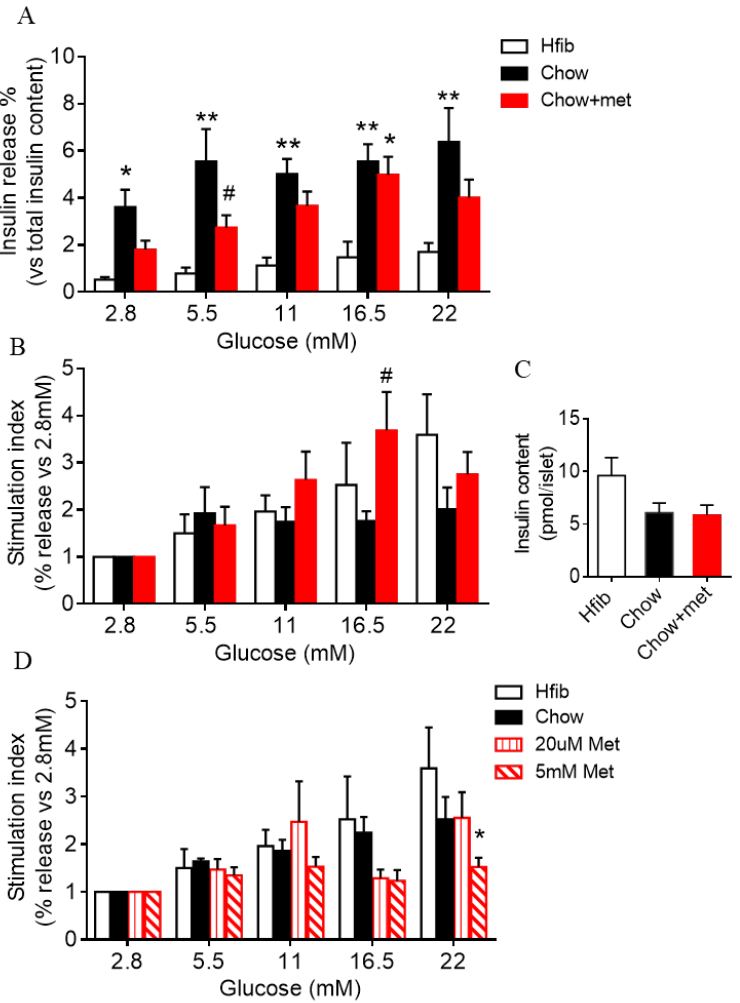
Figure 3. Islet glucose-stimulated insulin secretion (GSIS) was preserved in metformin-treatment NRs. ( A , B ): GSIS of islet isolated from NRs presented as percentage insulin release relative to islet insulin content ( A ) or baseline insulin secretion at 2.8 mM glucose ( B ); ( C ): average islet insulin